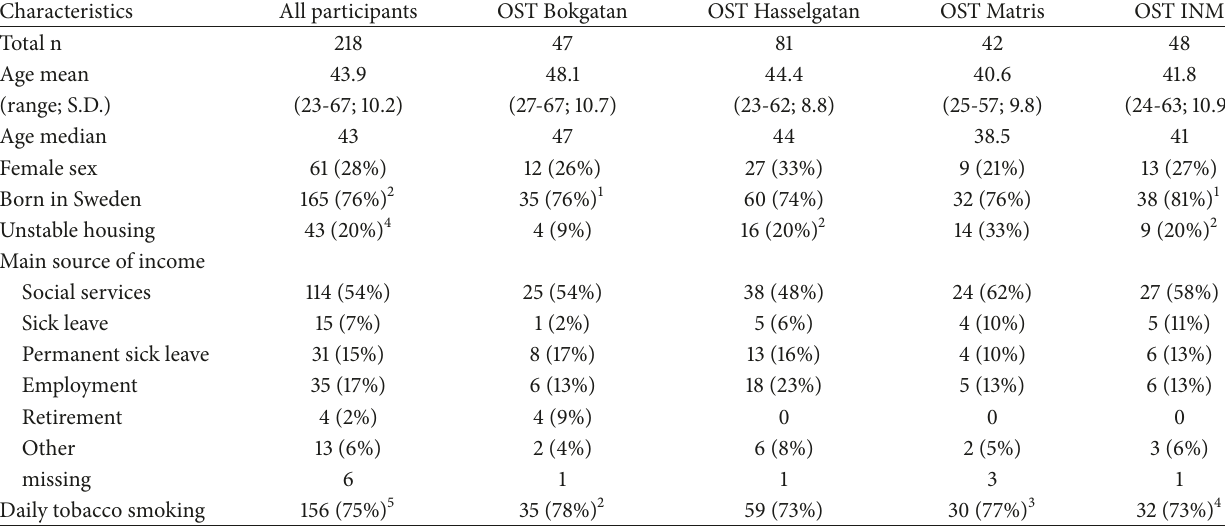
Table 1: Patient characteristics, N=218. (Missing values excluded from the